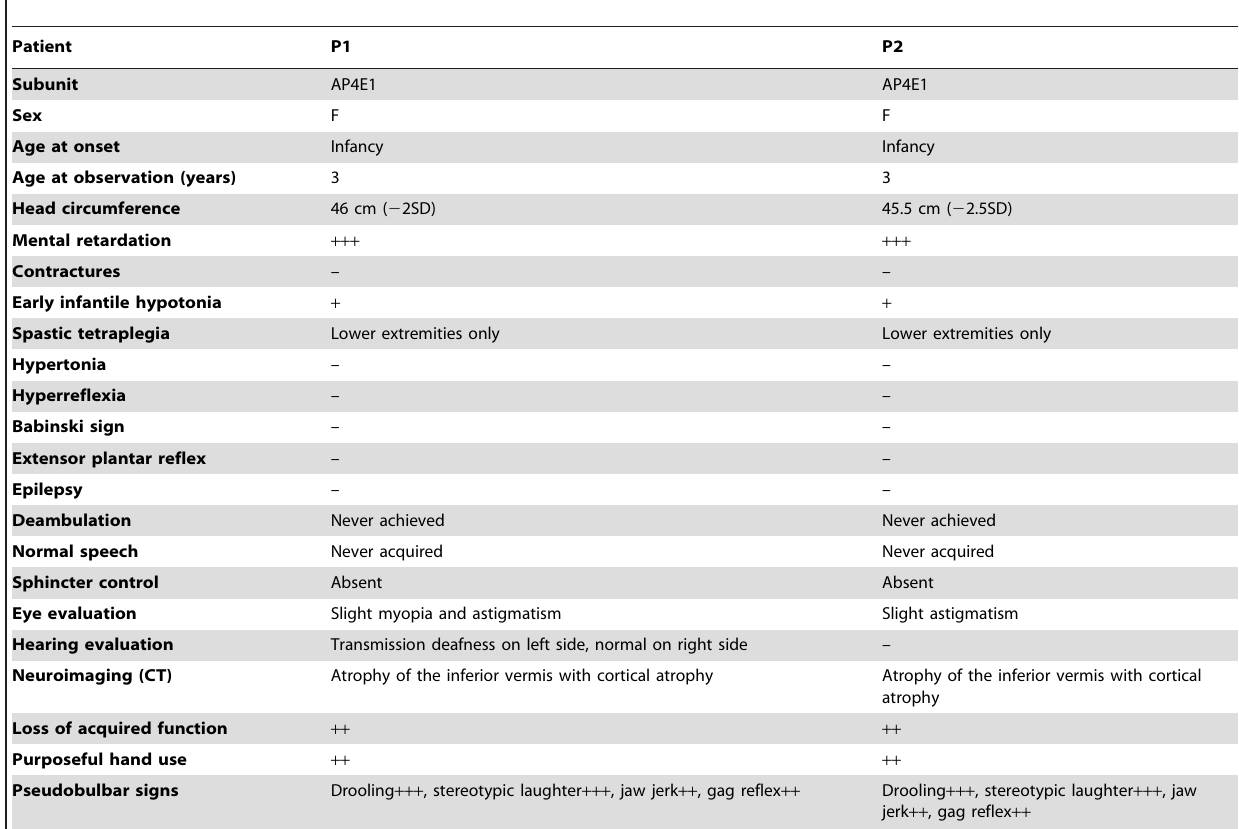
Table 1. Summary of clinical neurological